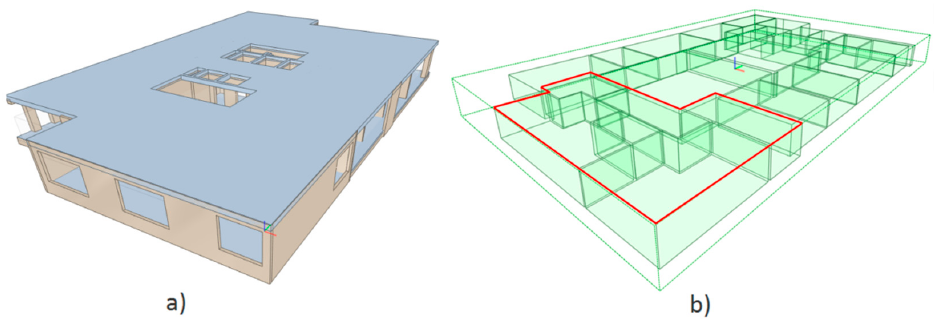
Figure 8. ( a ) BIM model of the 6th story; ( b ) Representation of spaces contained in the 6th story. The extraction of separate property units (like apartments or common areas) would be provided by the proposed IfcBuildingPropertyUnit class. One instance of a proposed class is represented in the model in Figure 9. It defines one apartment, located on the sixth story. The model represents the legal boundaries of an observed apartment. This is conducted completely in accordance with the definition for the proposed class, the IfcBuildingPropertyUnit. In the domain of geometry of the legal space, its footprint edges coincide with the outer edges of the outer boundaries or midline inner boundary ele- ments. The height of the representation encompasses the distance between the midlines of the intermediate boundary elements. Thus, the geometric representation of this legal space matches with the 3D geometry of the legal possession limits, which is proposed by Višnjevac et al. [42]. In such a way, the IFC data could automatically provide 3D geome- try in the registering process.